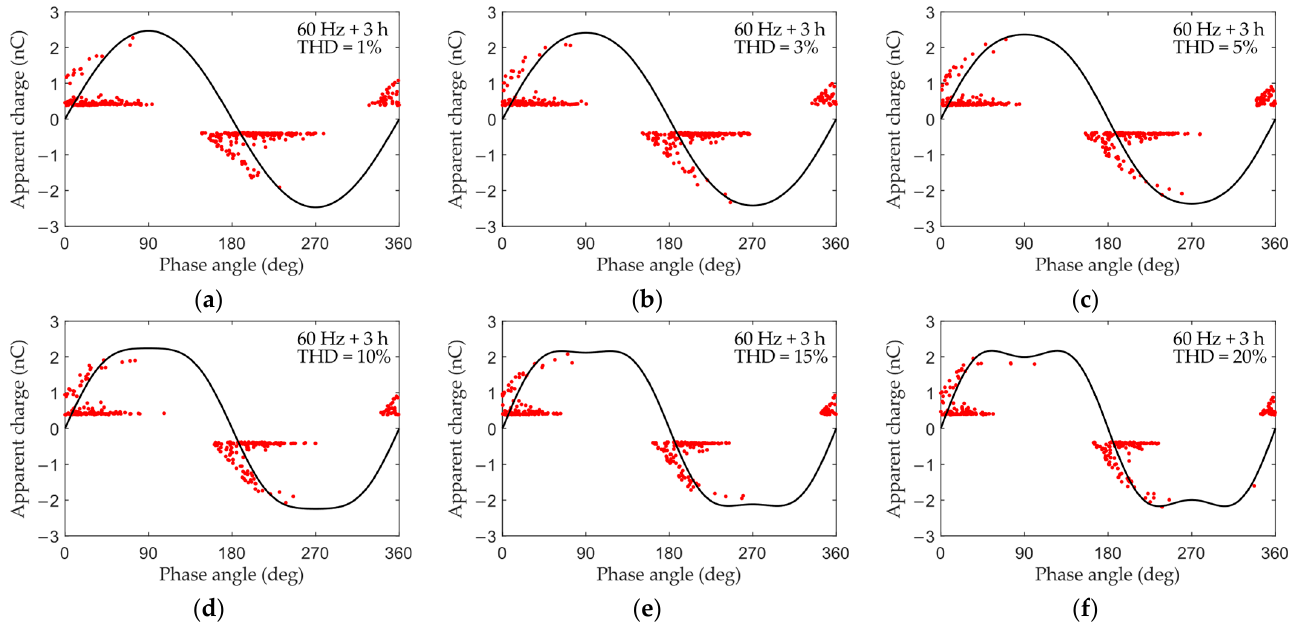
Figure 10. PRPD patterns obtained in the simulations for the cases wherein voltages distorted by the 3rd harmonic component was applied with ϕ h = 0 ◦ and THD =: ( a ) 1%; ( b ) 3%; ( c ) 5%; ( d ) 10%; ( e ) 15%; ( f ) 20%.